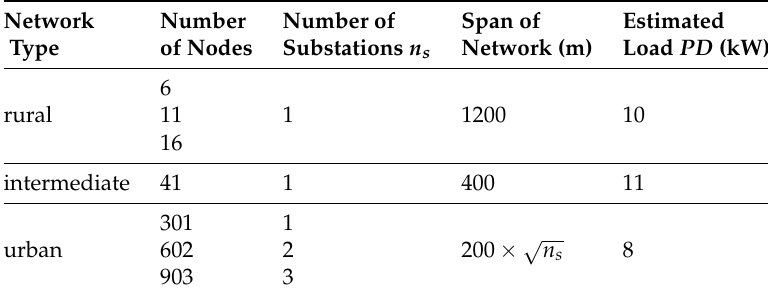
Table 2. Network